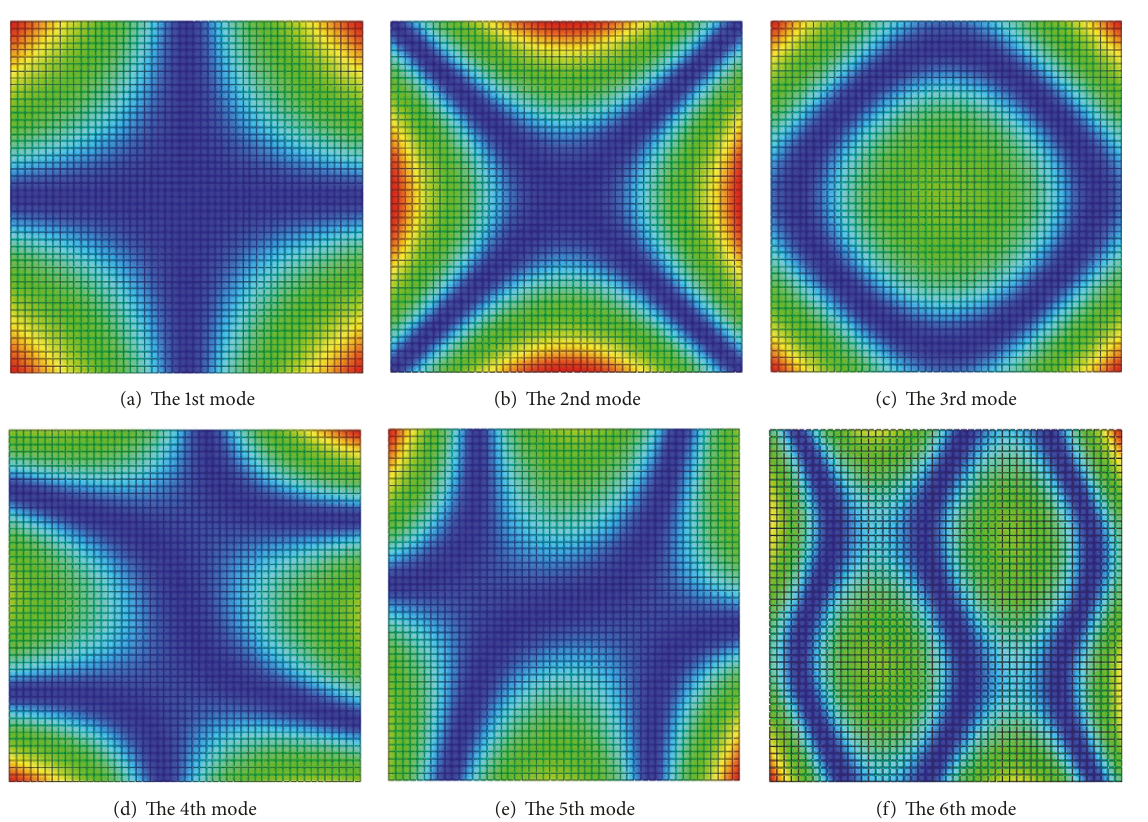
= 𝜉 = 10 2 , 𝜉 = 0 , 𝐾 𝑖 𝐾 𝑖𝑗 𝑖